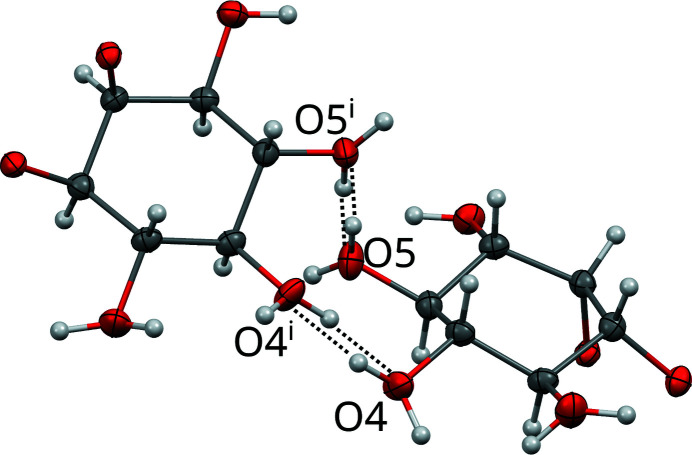
Hydrogen bonds disordered about a 2[010] rotation axis connecting two I half-layers of 1 in the basic structure. The viewing direction is distinctly inclined to [010]. Hydroxyl groups featuring two H atoms are disordered in a 1:1 manner. Hydrogen atoms without apparent acceptor connect inside the I layers. Symmetry code: (i) 2 0,y,½. Atom colors as in Fig. 4 ▸.